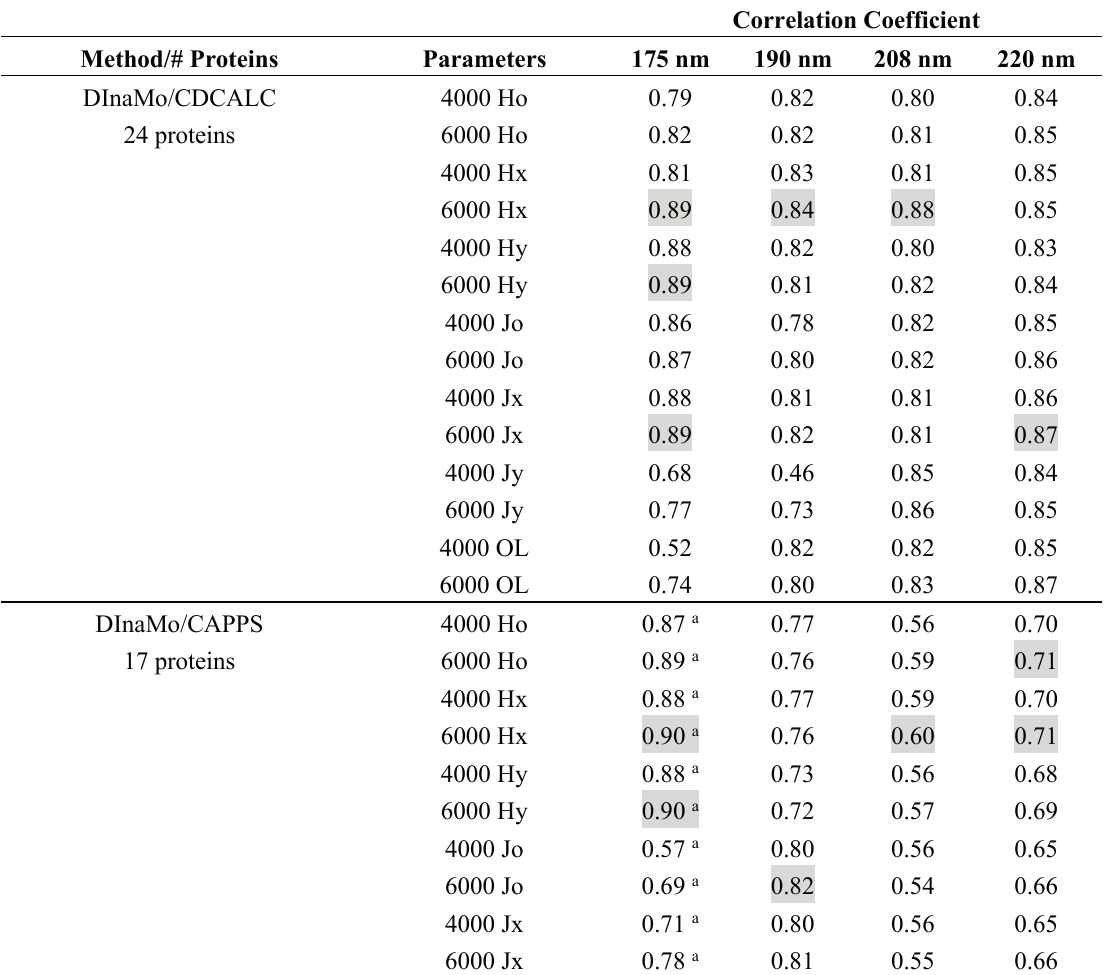
Table 5. Spearman Rank Correlation Coefficients for Calculated Far-UV